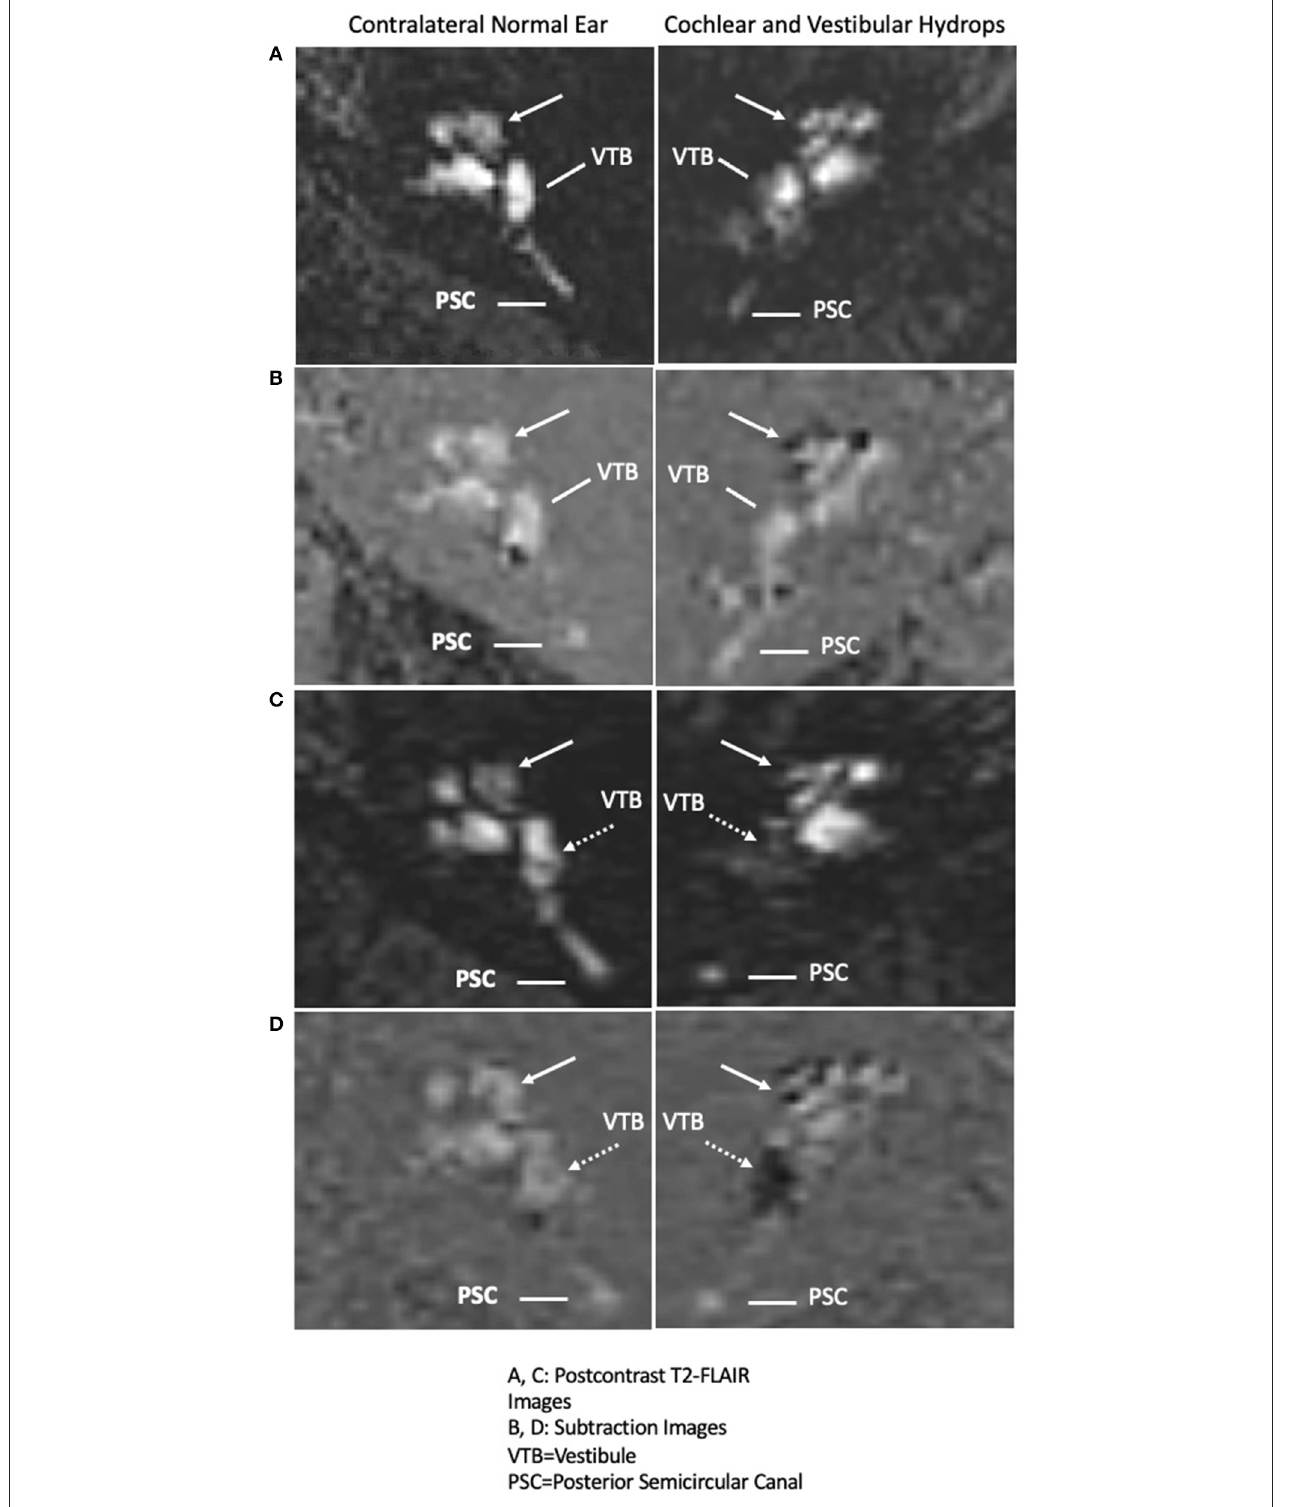
FIGURE 2 | Interval progression of cochlear endolymphatic hydrops in 2015 to cochlear and vestibular endolymphatic hydrops in 2019 on 3T MRI: Right column: Endolymphatic hydrops and Left column: contralateral normal ear. (A) (Right panel: Cochlear hydrops in 2015 MRI), delayed postcontrast T2-FLAIR images through